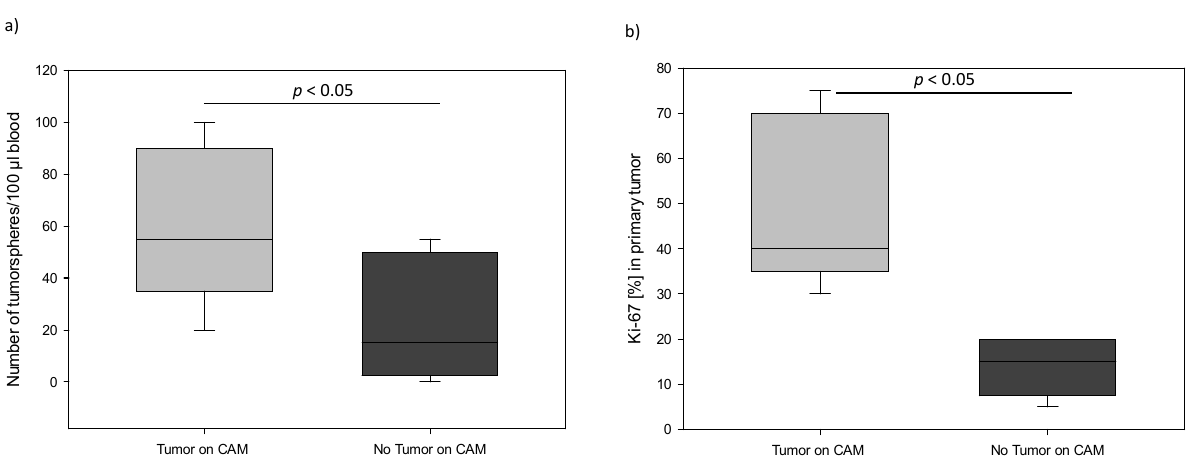
Figure 5. ( a ) Development of a microtumor from tumorspheres of breast cancer patient on CAM membrane. Scale bar = 5 mm; magnification ×20. ( b ) H&E and pan-cytokeratin staining of a CAM xenograft developed from tumorspheres in light microscopy. Scale bar = 100 µm for H&E, scale bar = 200 µm for pan-cytokeratin; magnification ×200.